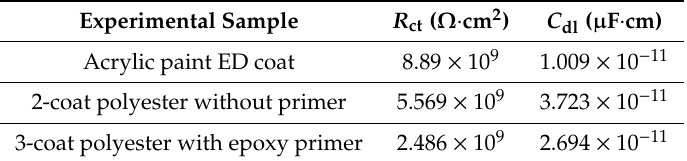
Table 3. Electrochemical impedance spectroscopy results.